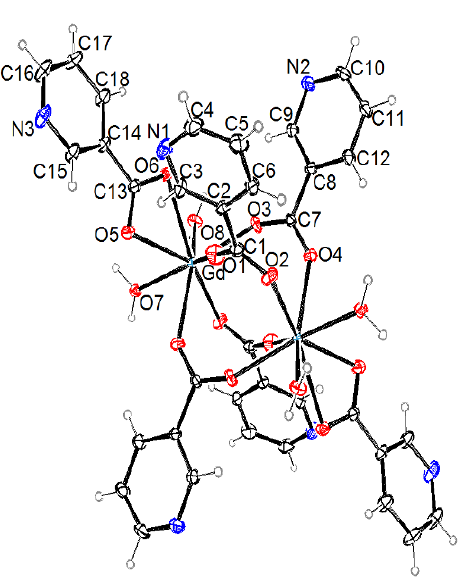
Figure 1. ORTEP drawing of coordination molecules of 1 . Ellipsoids are at 30% probability level. Labelled are non-H atoms from the asymmetric unit.